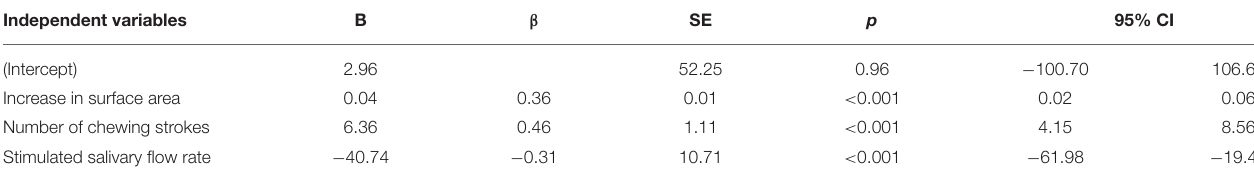
TABLE 1 | Multiple regression analysis of aroma concentration. Independent